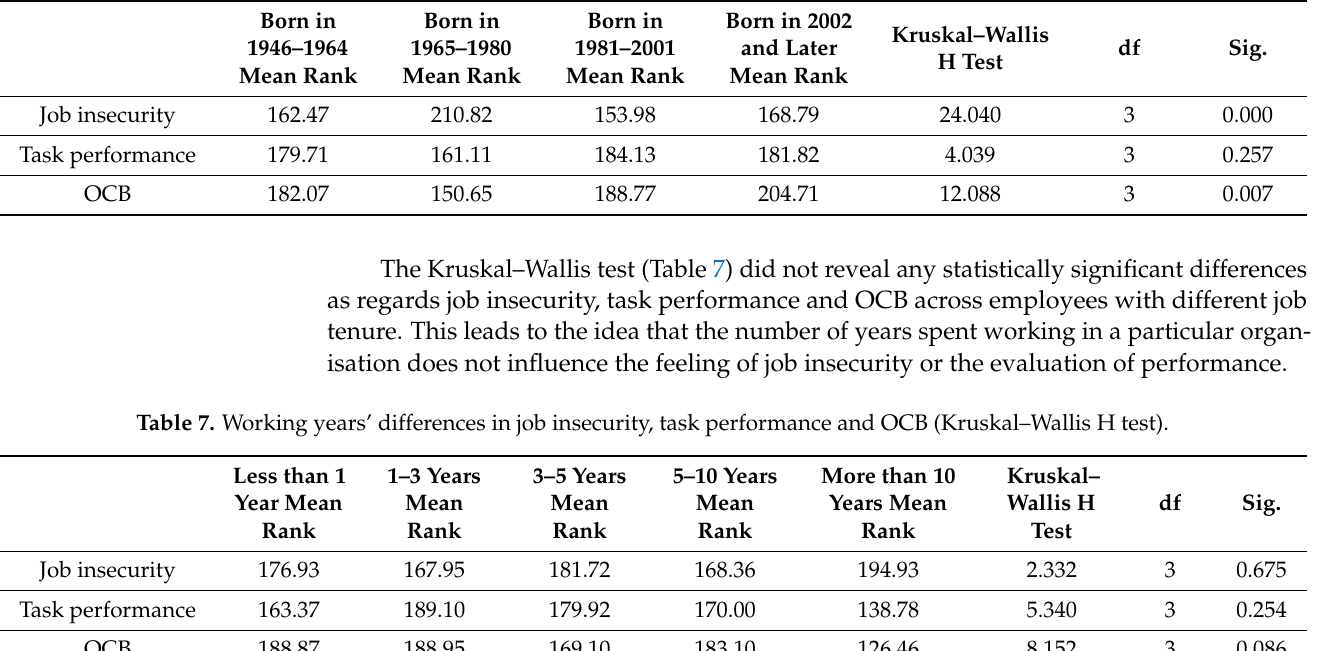
Table 6. Age differences in job insecurity, task performance and OCB (Kruskal –Wallis H test).